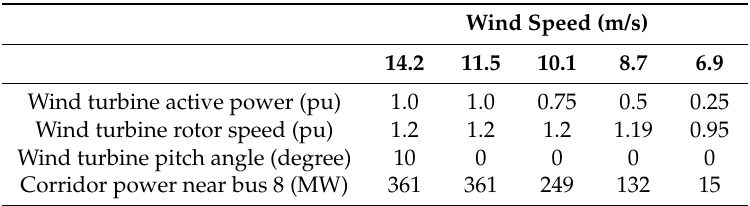
Table 3. System information under different wind speeds.